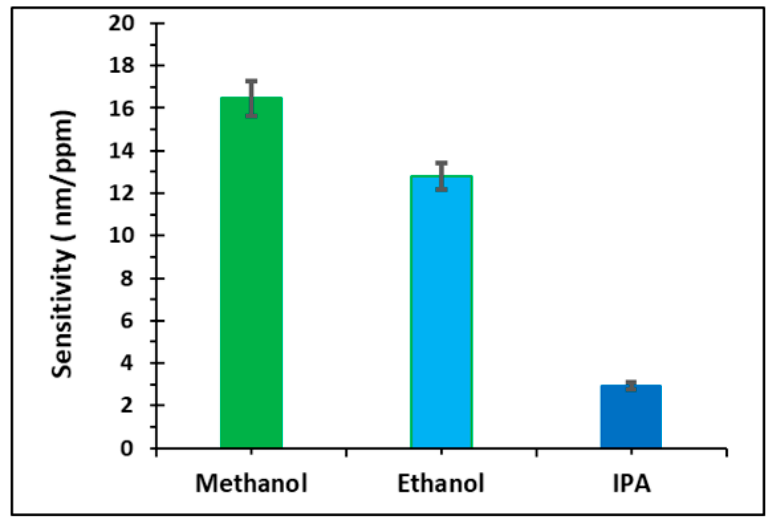
Figure 5. Sensitivity +/ − ~5% of the PMMA-coated MCLs to the three alcohol vapors tested.